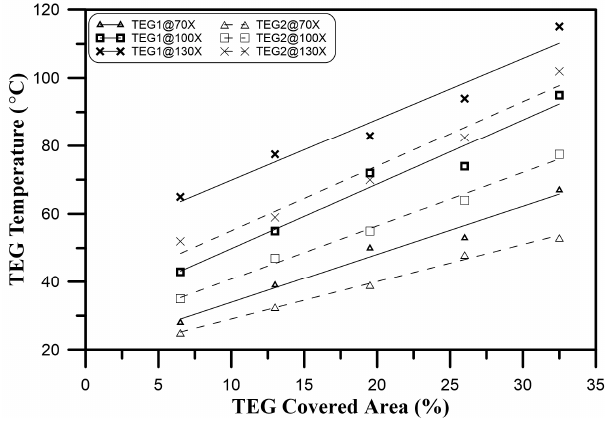
Figure 4. TEGs’ temperature increased as a function of increasing the covered area of their surfaces.